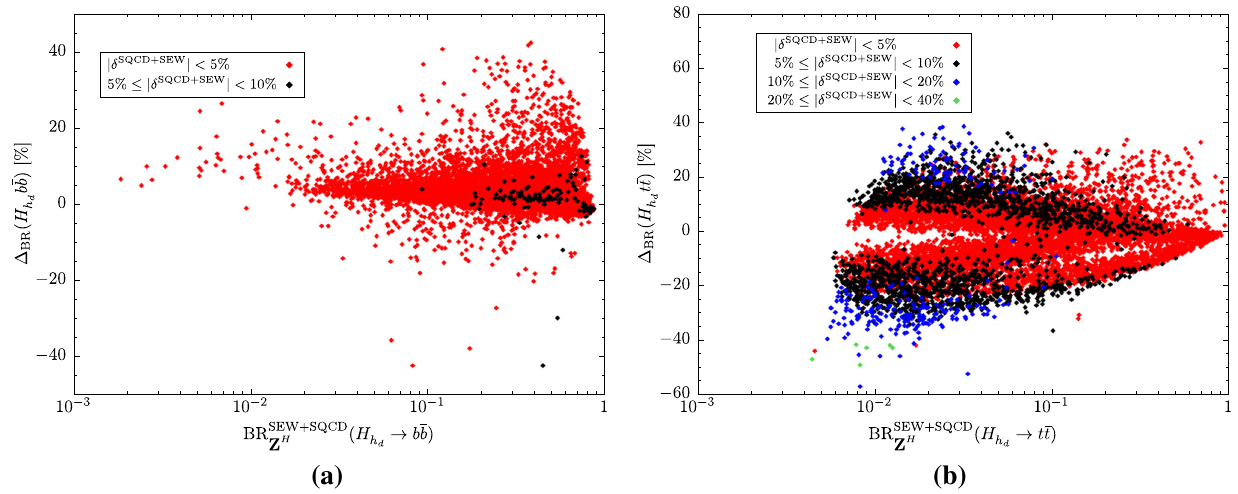
Fig. 6 Scan2: Same as Fig. 2 but for the heavier h d -like Higgs boson H h